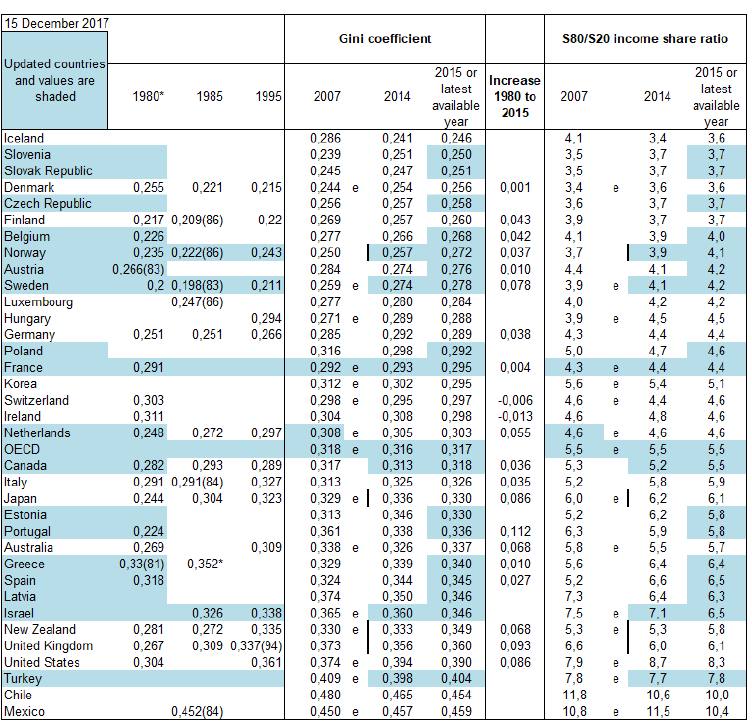
Table 3: Inequality Indicators for the OECD countries (Gini coefficient and ratio of top 20 percent to bottom 20 percent)